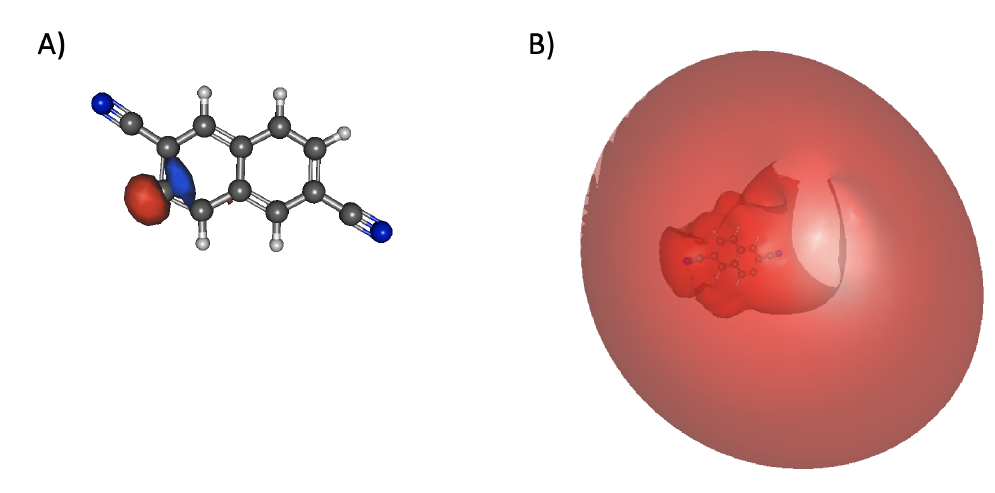
Figure 4. The orbitals for the quadrupole-bound candidate state of 2-dicyanonaphthalene-34: ( A ) a (cid:48) HOMO & ( B ) a (cid:48) quadrupole-bound